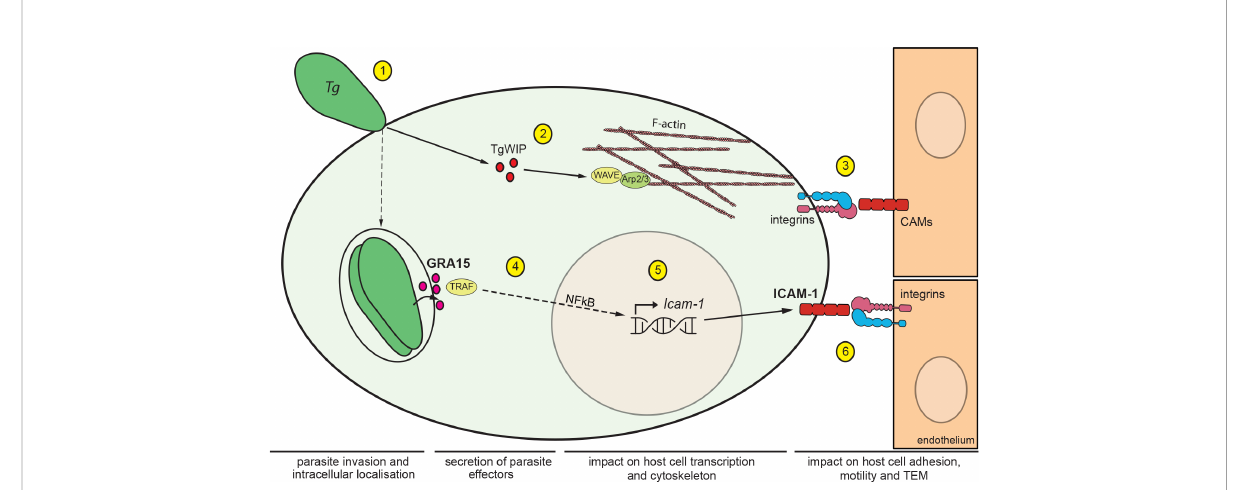
FIGURE 5 Impact of T. gondii secreted effectors on ICAM-1 expression and TEM of DCs. Schematic illustration of the signalling pathways mediating migratory activation and TEM of T. gondii -infected DCs across polarised endothelium. (1) T. gondii ( Tg ) actively invades leukocytes by its own actinomyosin-driven gliding motility and replicates intracellularly in the non-fusogenic parasitophorous vacuole (PV) surrounded by the PV membrane. (2) Upon invasion, the rhoptry secretory organelles are discharged into the host cell cytosol. The secreted effector TgWIP interacts with the host WAVE complex, which regulates fi lamentous (F)-actin dynamics via the Arp2/3 complex and drives enhanced cell motility (21). (3) In hypermigratory infected DCs, interactions between leukocyte b 1/ b 2 integrins and endothelial cell adhesion molecules, including ICAM-1, regulate the TEM of DCs. Notably, infected DCs transit from integrin-independent amoeboid motility in extracellular matrix to integrin-dependent migration on endothelium. This motility mode switch facilitates TEM (24). (4) Following invasion, T. gondii replicates within the formed PV and secretes the dense granule protein GRA15, which is exported to the host cytosolic side of the PV membrane. GRA15 interacts with TNF receptor associated factors (TRAFs) that mediate translocation of the transcription factor NF k B to the host cell nucleus (23). (5) Nuclear NF k B activates transcription of Icam-1 in the host cell nucleus with elevated mRNA expression in infected DCs, GRA15-dependently and in the absence of a by-stander effect. (6) Elevated expression of ICAM-1 at the DC membrane enhances cell adhesion, reduces cell motility and elevates TEM frequency via interactions with endothelial integrin